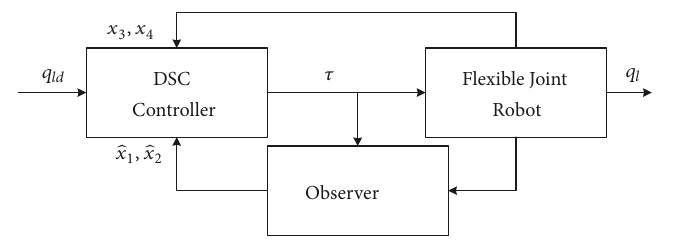
Figure 1: Controller